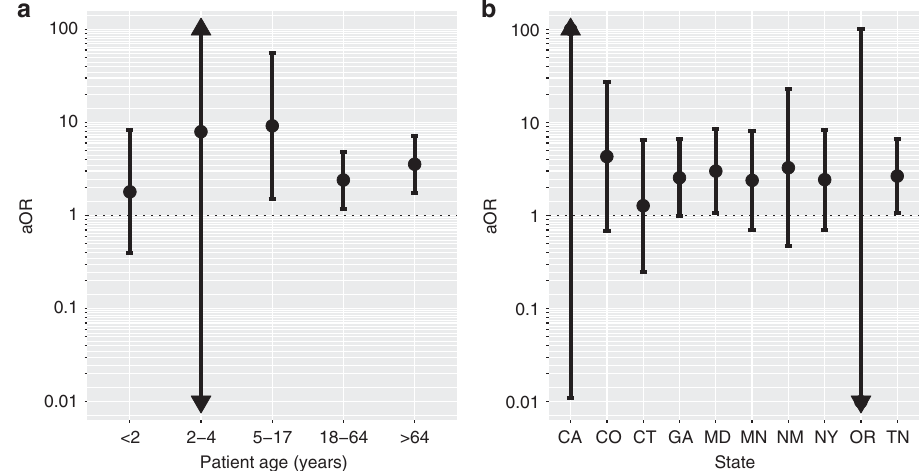
Fig. 5 Effect size of the pbp1b 641C genotype on meningitis syndrome in the con fi rmatory cohort. a Effect size strati fi ed by patient age group. b Effect size strati fi ed by surveillance state. Solid dot indicates the adjusted odds ratio (aOR) of pbp1b 641C estimated from a mixed-effects logistic regression model explicitly accounting for pneumococcal serotype (random effects), and susceptibility to six β -lactam antibiotics (random effects). Error bars are 95% con fi dence intervals. An arrow indicates the boundary of the estimated value is beyond the y -axis